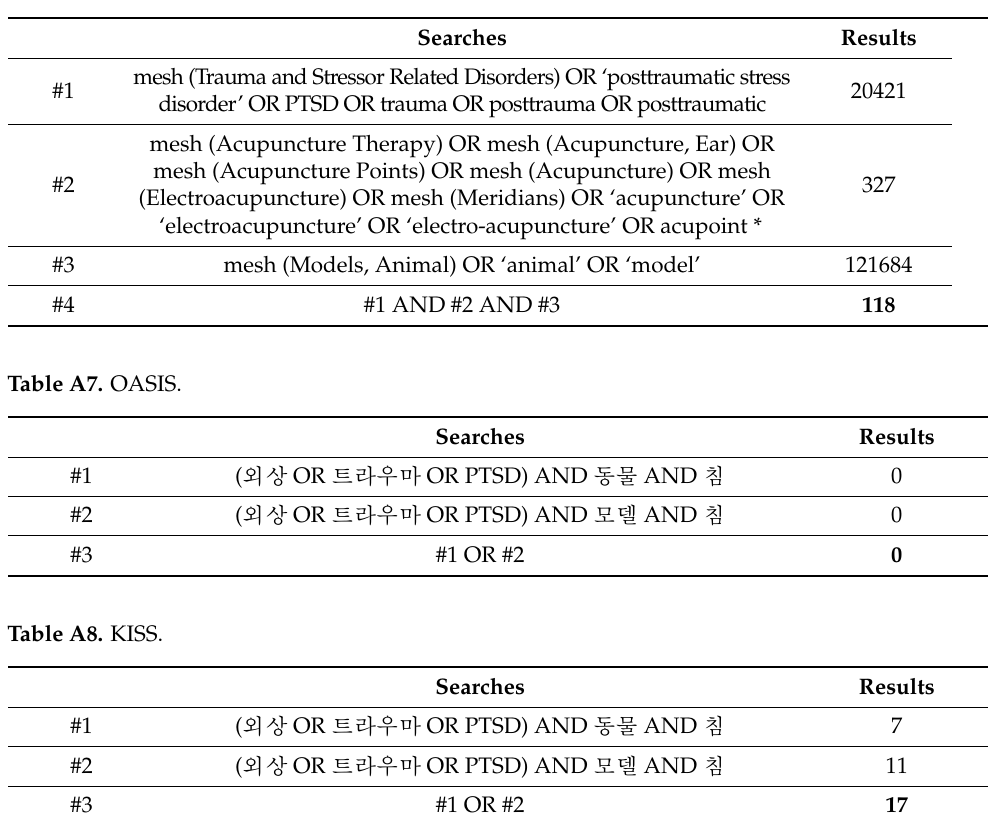
Table A6. PsycARTICLES via ProQuest.